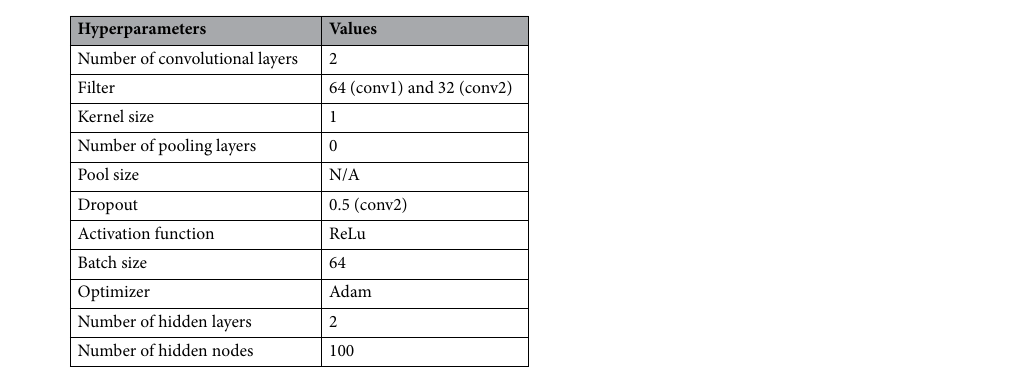
Table 7. Optimized combination of tuned